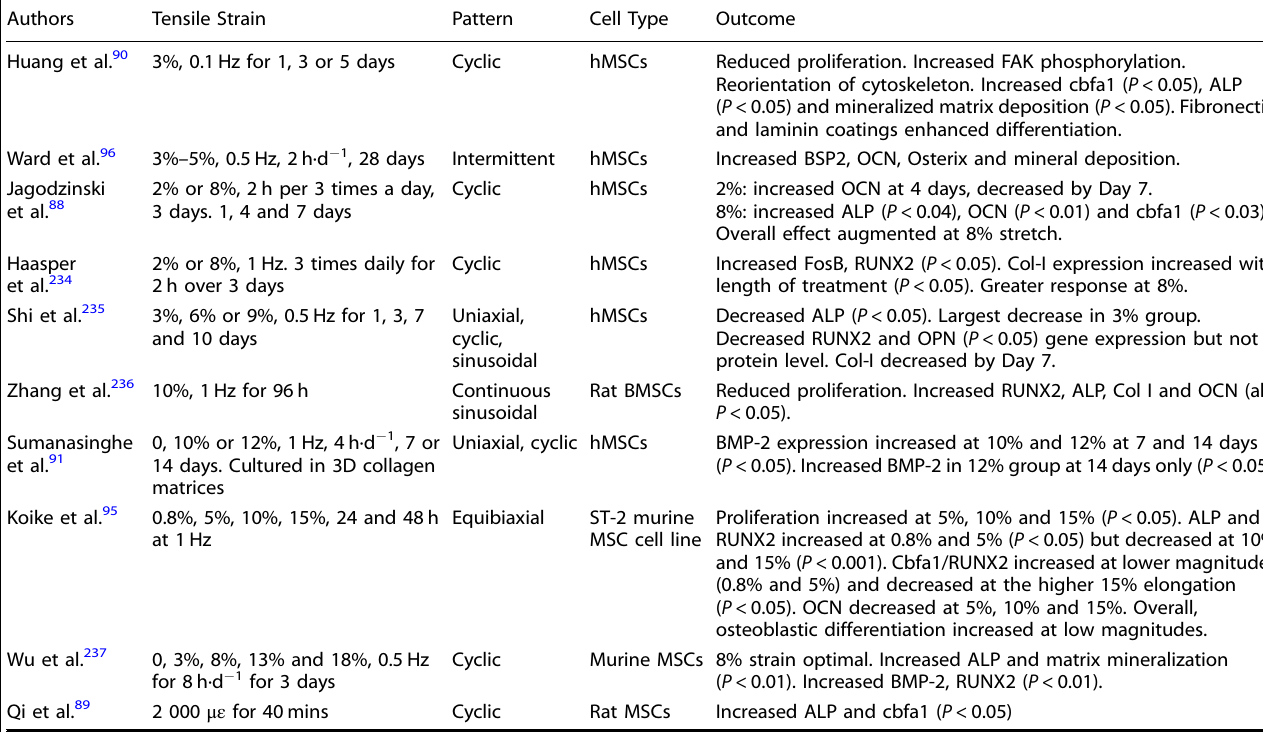
Studies are presented in increasing order of strain and according to cell type hMSCs human mesenchymal stem cells, Col-1 collagen-1, OCN osteocalcin, ALP alkaline phosphatase, RUNX 2 runt-related transcription Factor 2, cbfa1 core binding factor alpha 1, FAK focal adhesion kinase, OPN osteopontin, cpm cycles per minute, TGF- β transforming growth factor-1, BGH3 TGF- β 1-induced protein ig-h3, BMP2 bone morphogenetic